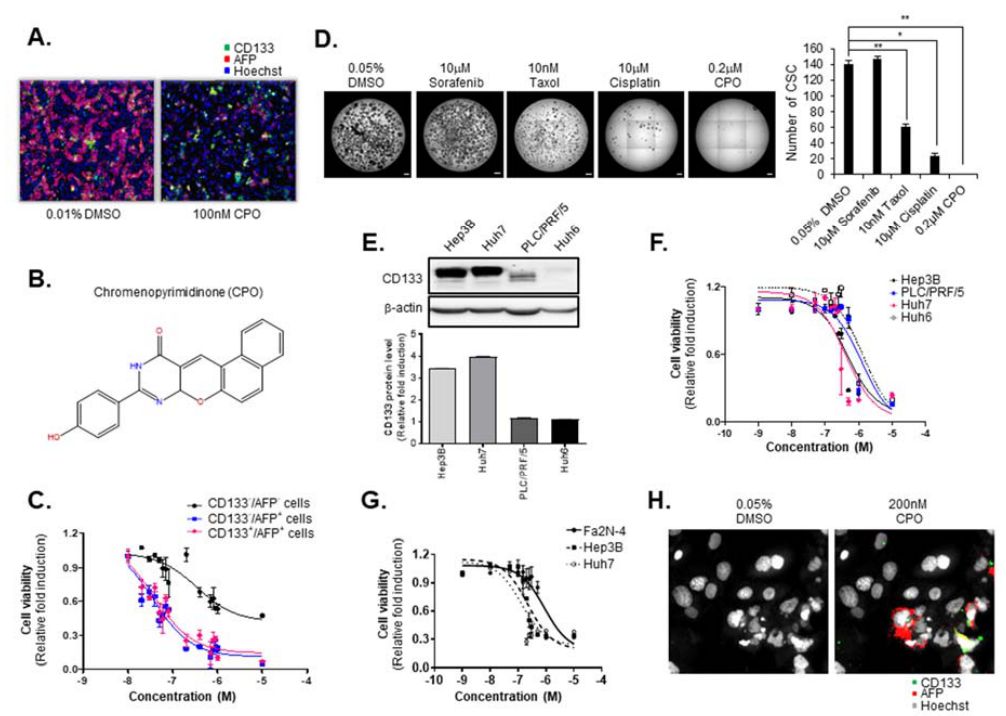
Figure 1. Suppression of liver cancer stem cells (LCSCs) and hepatocellular carcinoma (HCC) by chromenopyrimidinone (CPO). ( A ) Normal hepatocytes, cancer cells, and CSCs in a mixed culture system using Fa2N ‐ 4 and Huh7.5 after treatment with 100 nM CPO for 48 h. ( B ) Chemical structure of chromenopyrimidinone (CPO). ( C ) Viability of normal hepatocytes (AFP − /CD133 − ), cancer cells (AFP + /CD133 − ), and CSCs (AFP + /CD133 + ) in mixed culture systems at the indicated concentration. ( D ) CSC spheroid formation after treatment with 10 nM Taxol, 10 μ M cisplatin, 10 μ M sorafenib and 0.2 μ M CPO for 3 days (left panel). The number CSC were counted (right panel). Scale bar = 500 μ m. ( E ) Expression of CD133 in the Hep3B, Huh7, PLC/PRF/5, and Huh6 hepatocellular carcinoma cell lines (upper panel). Expression of CD133 was quantified (lower panel). β‐ actin was used as the control. (whole blot image, Figure S1). ( F ) Viability of HCC cell lines (Hep3B, PLC/PRF/5, Huh7, and Huh6) after treatment with the indicated concentration of CPO for 48 h. ( G ) Viability of Fa2N ‐ 4, Hep3B, and Huh7 cells after treatment with the indicated concentration of CPO for 48 h. ( H ) Morphology of cancer cell and CSC nuclei after treatment with 200 nM CPO for 48 h. Images were acquired using a HCS system with a 40× objective. The data shown are from three independent experiments relative to the control values and the mean values ± SD from three independent experiments; * p < 0.05 and ** p < 0.01 compared to CPO treatment group.